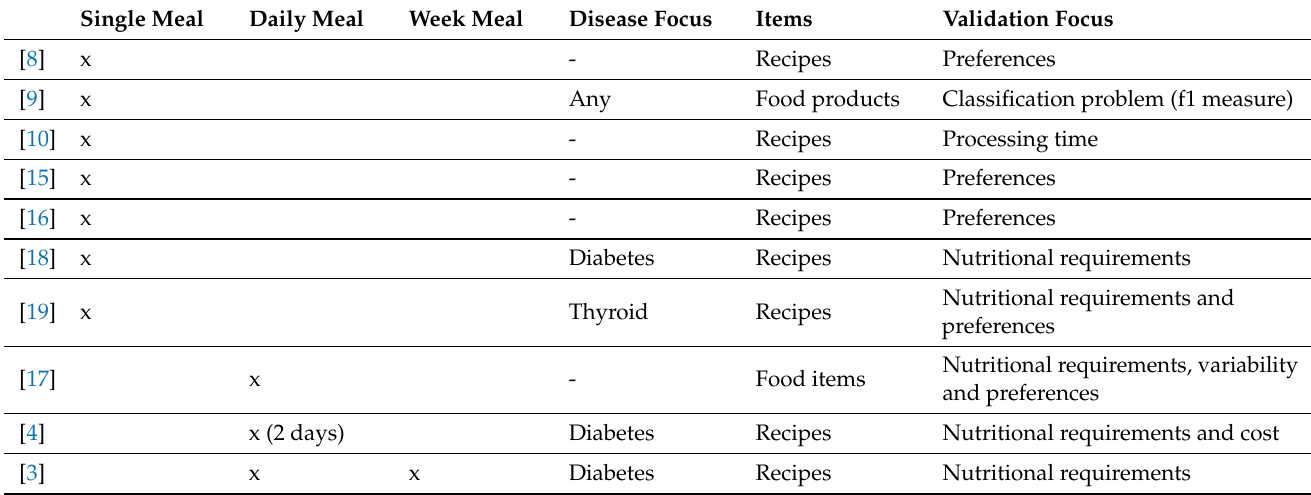
Table 1. Summary of the related work comparing the scope of meal recommendations, the disease they are focused in, the items used in recommendations, and the focus of their